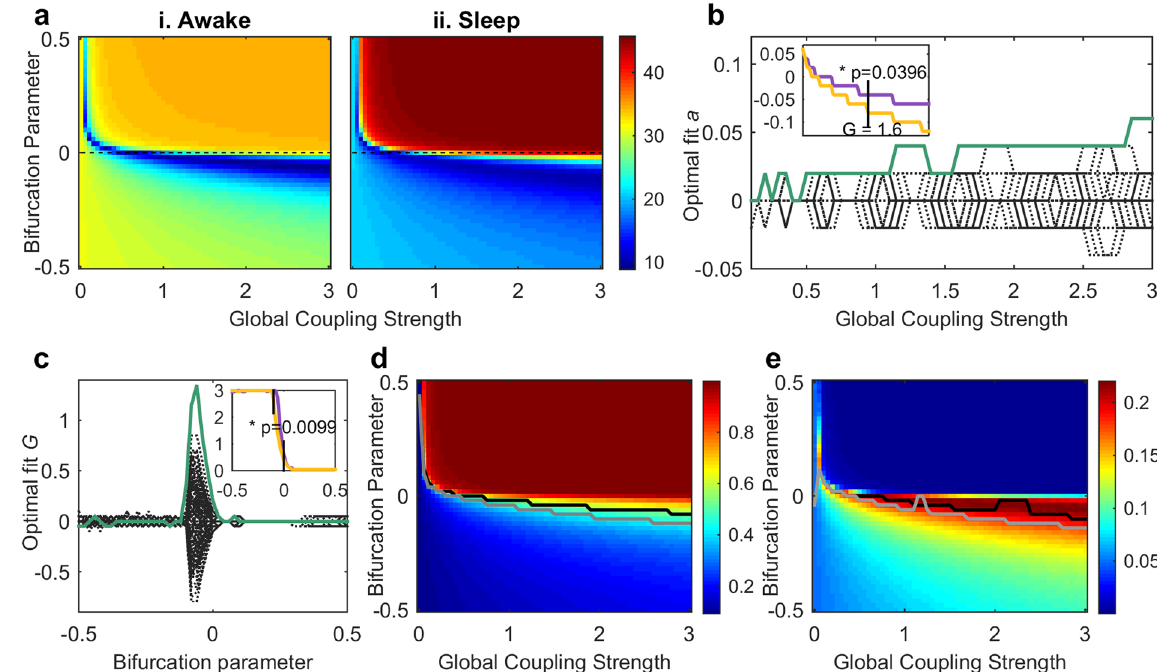
Figure 3. Whole-brain model parameter space exploration and fitting. ( a ) (i.,ii.) Euclidean distance between FC model and FC emp for different values of the global coupling strength G and the bifurcation parameter a in awake (i.) and sleep (ii.). Note that a is changed homogeneously over nodes. The optimal fit corresponds to a minimal Euclidean distance. In ( b ) the difference between the optimal Euclidean distance fit in awake and in sleep is shown as a function of G . The optimal fit is defined as the bifurcation parameter which corresponds to the minimum Euclidean distance for each value of G . The broken black lines represent the surrogate data constructed under the null-hypothesis of no difference between vigilance states, whereas the green line shows the difference between the optimal fit in awake and sleep. In the upper left corner the optimal fit for awake (violet) and sleep (yellow) is shown as a function of G . There is a significant difference between the two states from G = 1.6 onward with a corresponding p-value of 0.0396. In ( c ) the difference between the optimal Euclidean distance fit in awake and in sleep is displayed as a function of a . The broken black lines and the green line are to be read as in ( b ). In the upper right corner the optimal fit for awake (violet) and sleep (yellow) is shown as a function of a . There is a significant difference between the two states for − 0.1 ≤ a ≤ 0 with a corresponding p-value of 0.0099. ( d ) represents the simulated global synchrony as a function of G and the bifurcation parameter a . The black line shows the optimal fit for the awake state, namely the closest value to the empirical global synchrony for each G , as a function of the global coupling strength. The gray line shows the same for the sleep state. In ( e ) the simulated metastability is displayed, also here as a function of G and the bifurcation parameter. The black and the gray line are to be read as in ( d ). Note the observable global shift to more negative bifurcation parameter values in ( d ) and ( e